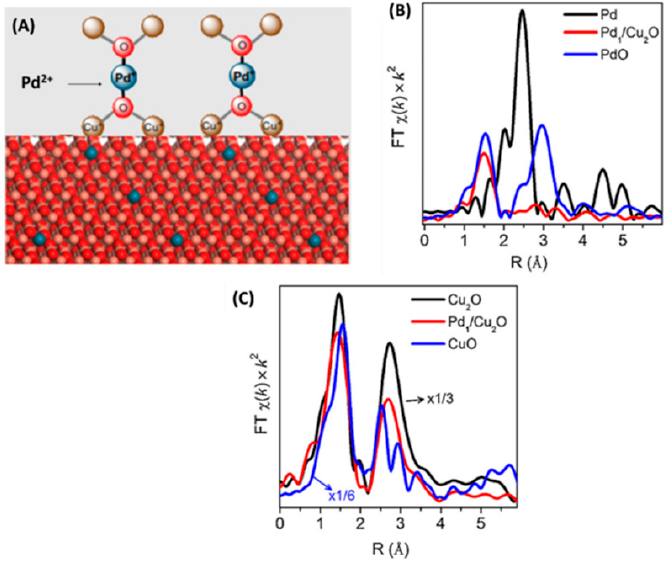
Figure 8. ( A ) state and coordination environment of Pd atomically dispersed on Cu 2 O surface. ( B ) a FT EXAFS of different Pd species ( C ) a FT EXAFS of different Cu species. Adapted from [26] with